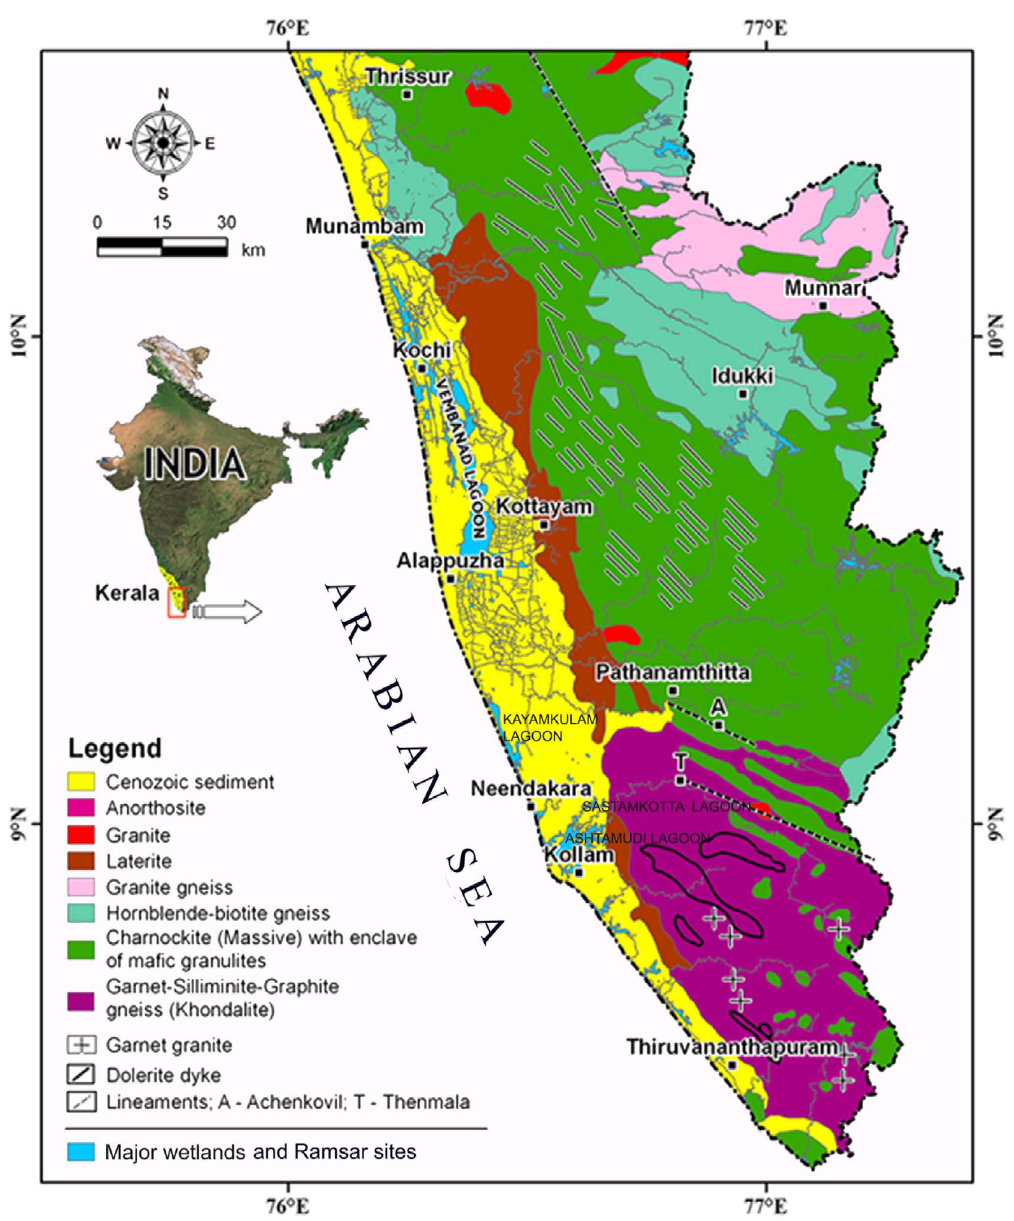
Figure 1. Location of major wetlands in Southwestern India showing geological formations/rock type and lineaments (Modified after